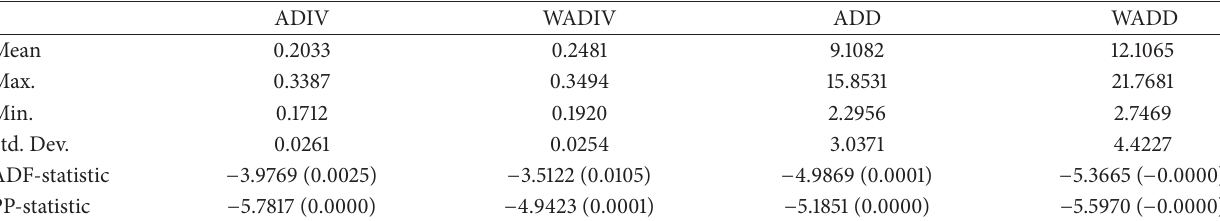
Table 1: Descriptive statistics, ADF, and PP tests.